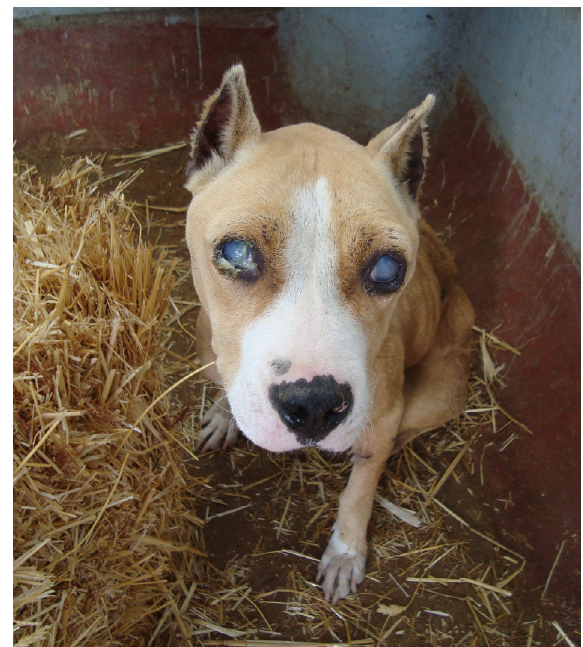
Figure 1. Bilateral purulent blue keratitis in a dog, with surra.